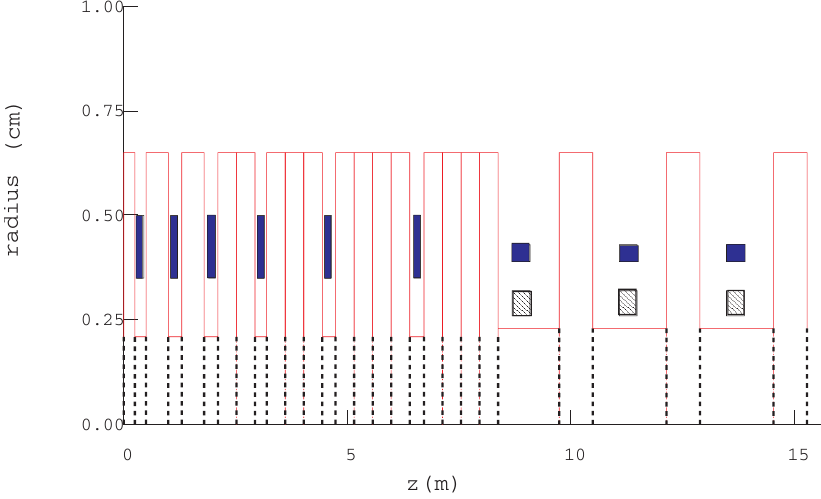
FIG. 20. (Color) Matching section from cooling to linac. Blue rectangles are solenoids, red lines are rf cavity walls and dashed black lines are the windows of the cavities. The last three cavities are superconducting, the remaining ones are room